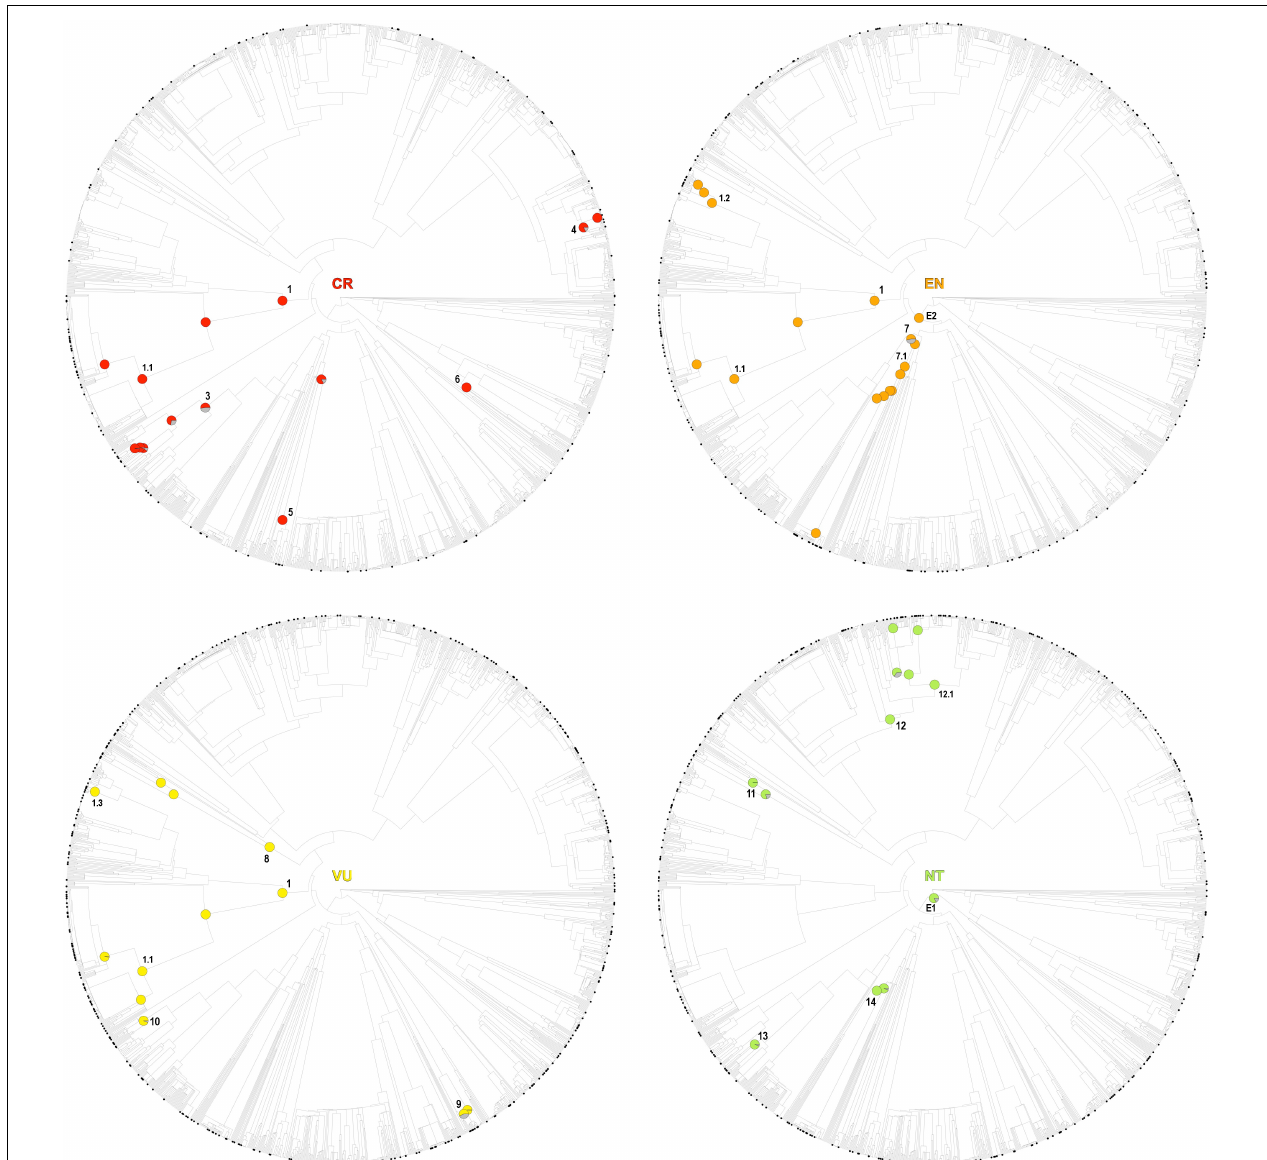
FIGURE 3 | One randomly selected tree topology for the endemic angiosperm flora of the Iberian Peninsula that included all the hot clades detected in the analysis (CR, EN, VU, and NT categories). Hot nodes are marked with pie charts, representing level of support for the nodes, this is, the number of times they were observed with statistical significance (5% nominal alpha) across all the trees analyzed. The circle symbols on the phylogenetic tips represent the species of each category. The numbers correspond to entries in Table 1 , where the identity of the nodes is